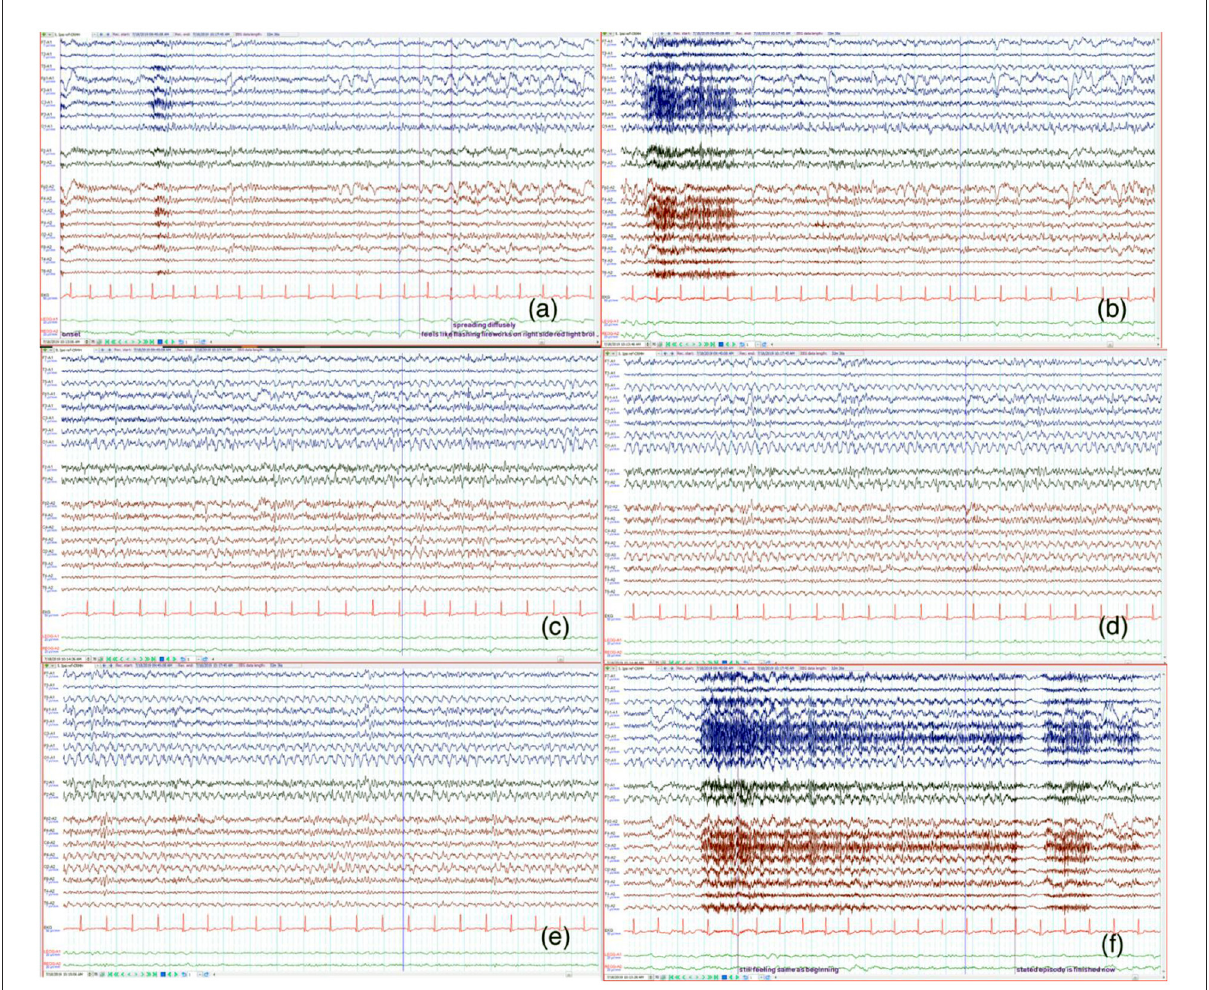
FIGURE1 The signals from the left hemisphere is shown in blue and right hemisphere in red. Twenty sec epochs of electroencephalography (EEG) (average montage) demonstrate that the onset is from the left occipital region (a) with evolution and progression (b–f) to involve the right side. The patient’s seizure correlated with the visual sensation of “flashing fireworks and broken red lights mirrors” in the patient’s right visual